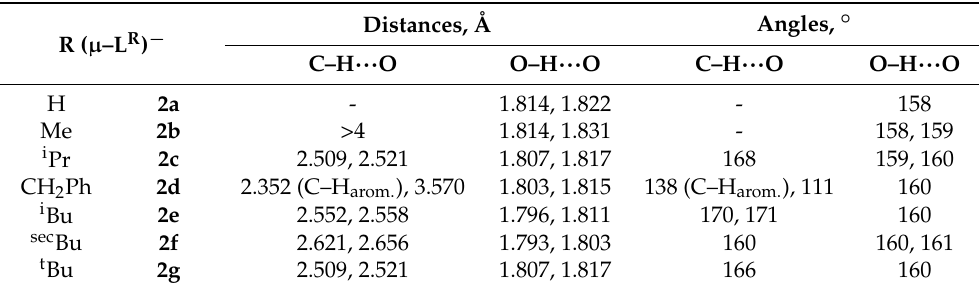
Table 2. Selected structural data for classical and nonclassical hydrogen bonds in optimized